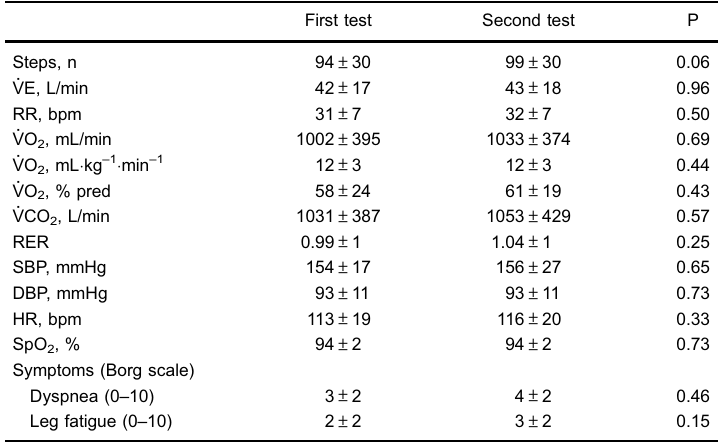
Table 2. Comparisons between variables at the peak of exercise between the fi rst and second six-minute step